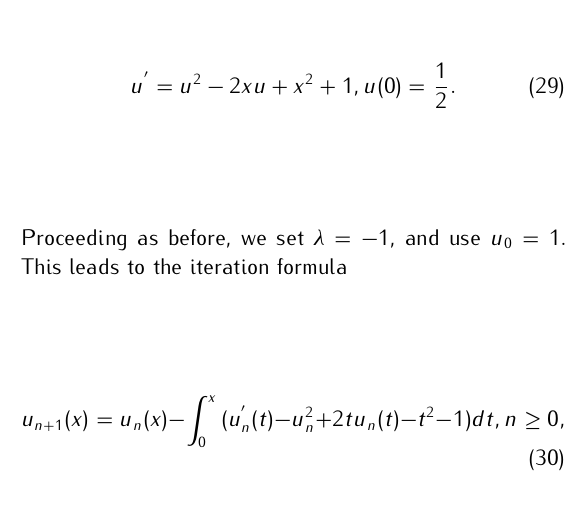
0 (0) increases with